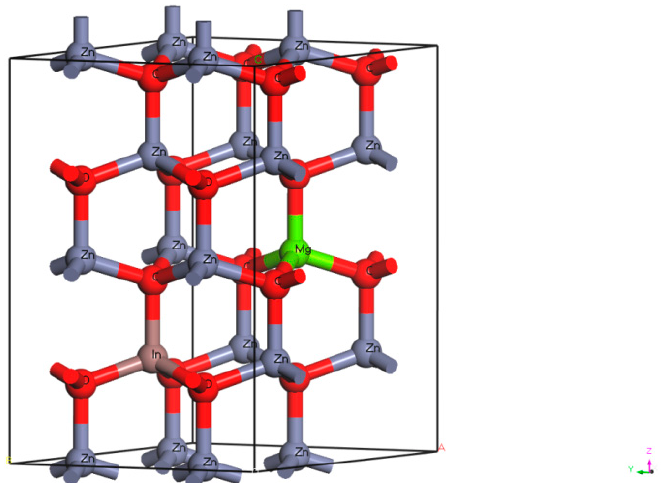
Figure 1. Crystal structure of ZnO super cell and doping position.